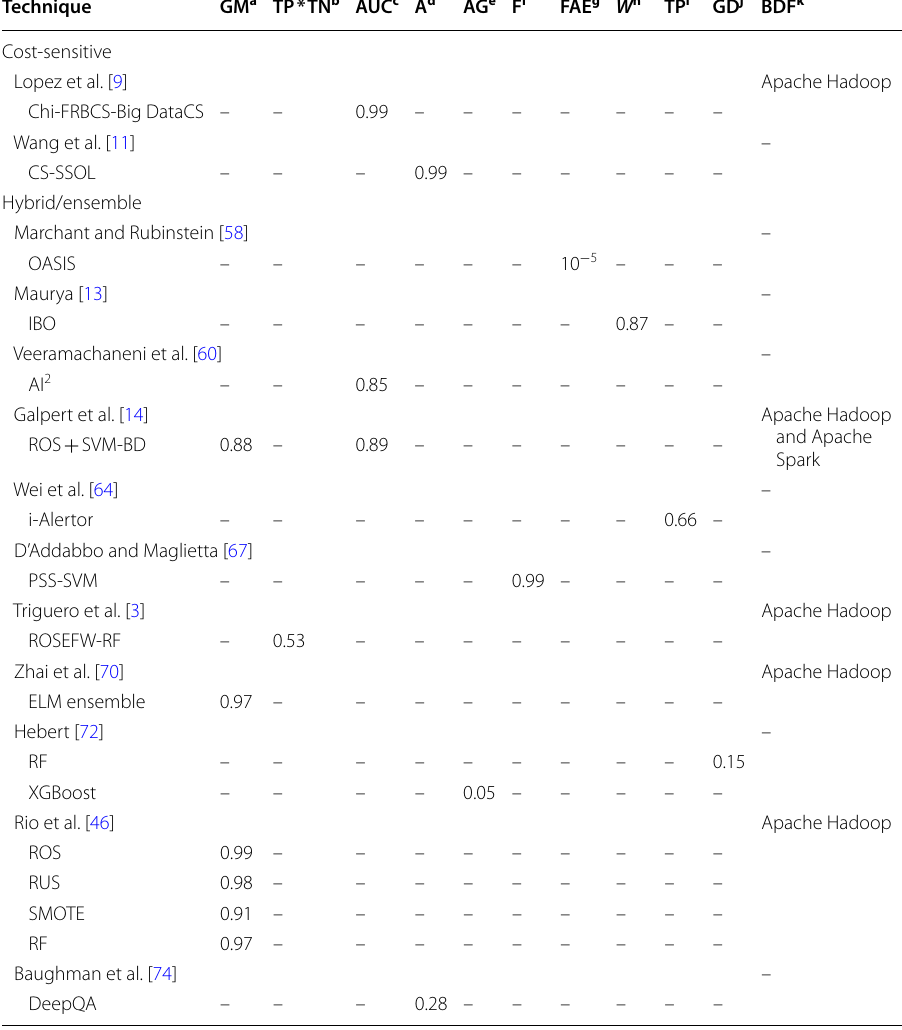
Table 4 Performances’ summary of algorithm-level